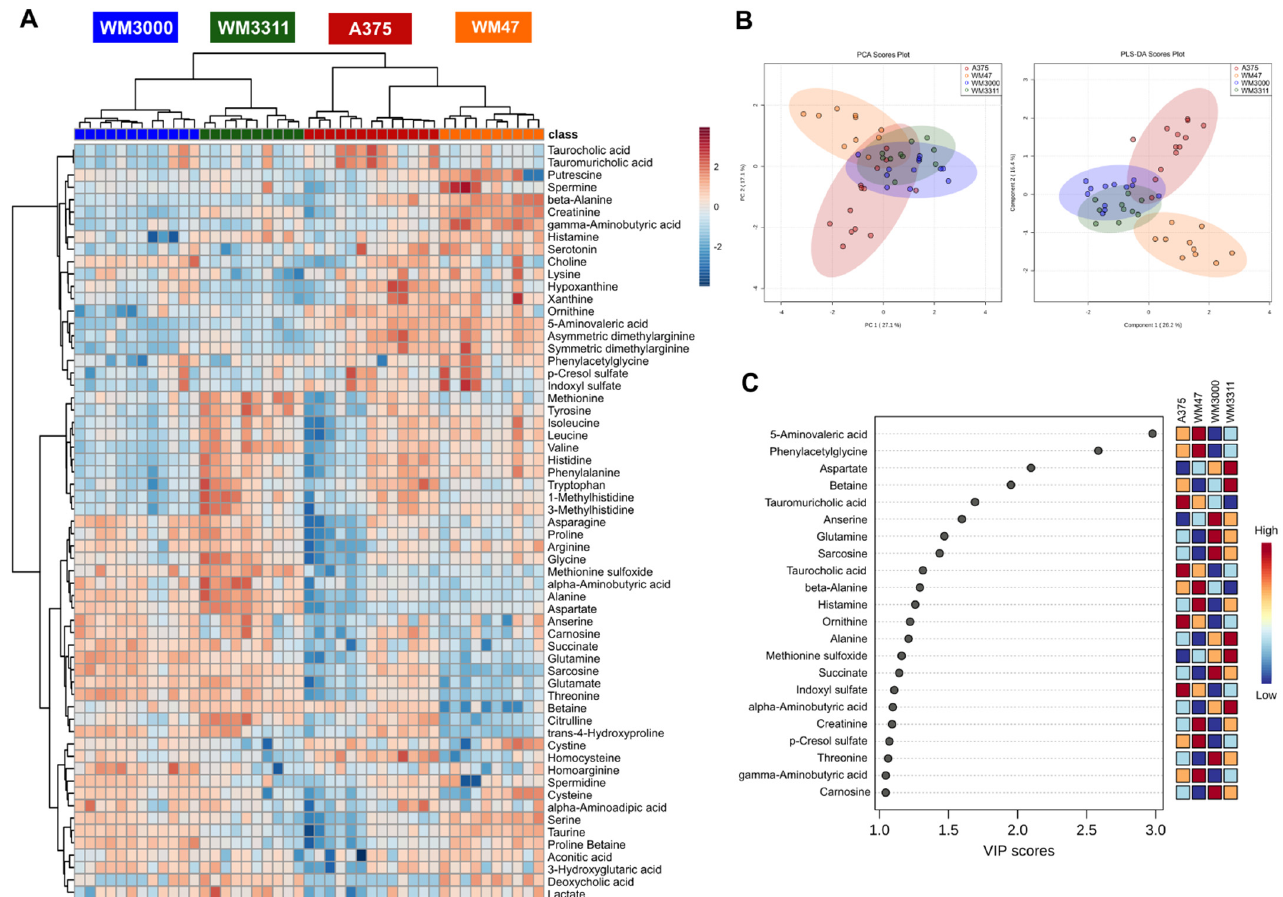
Figure 1. Metabolic analysis of hydrophilic/polar metabolites in melanoma xenografts. ( A ) Heatmap, ( B ) principal component analysis (PCA) and partial least squares-discriminant analysis (PLS-DA) scores, and ( C ) PLS-DA variable importance in projection (VIP) score derived from the hydrophilic/polar metabolite profiling data of A375, WM47, WM3000, and WM3311 melanoma xenografts; n = 10–13.